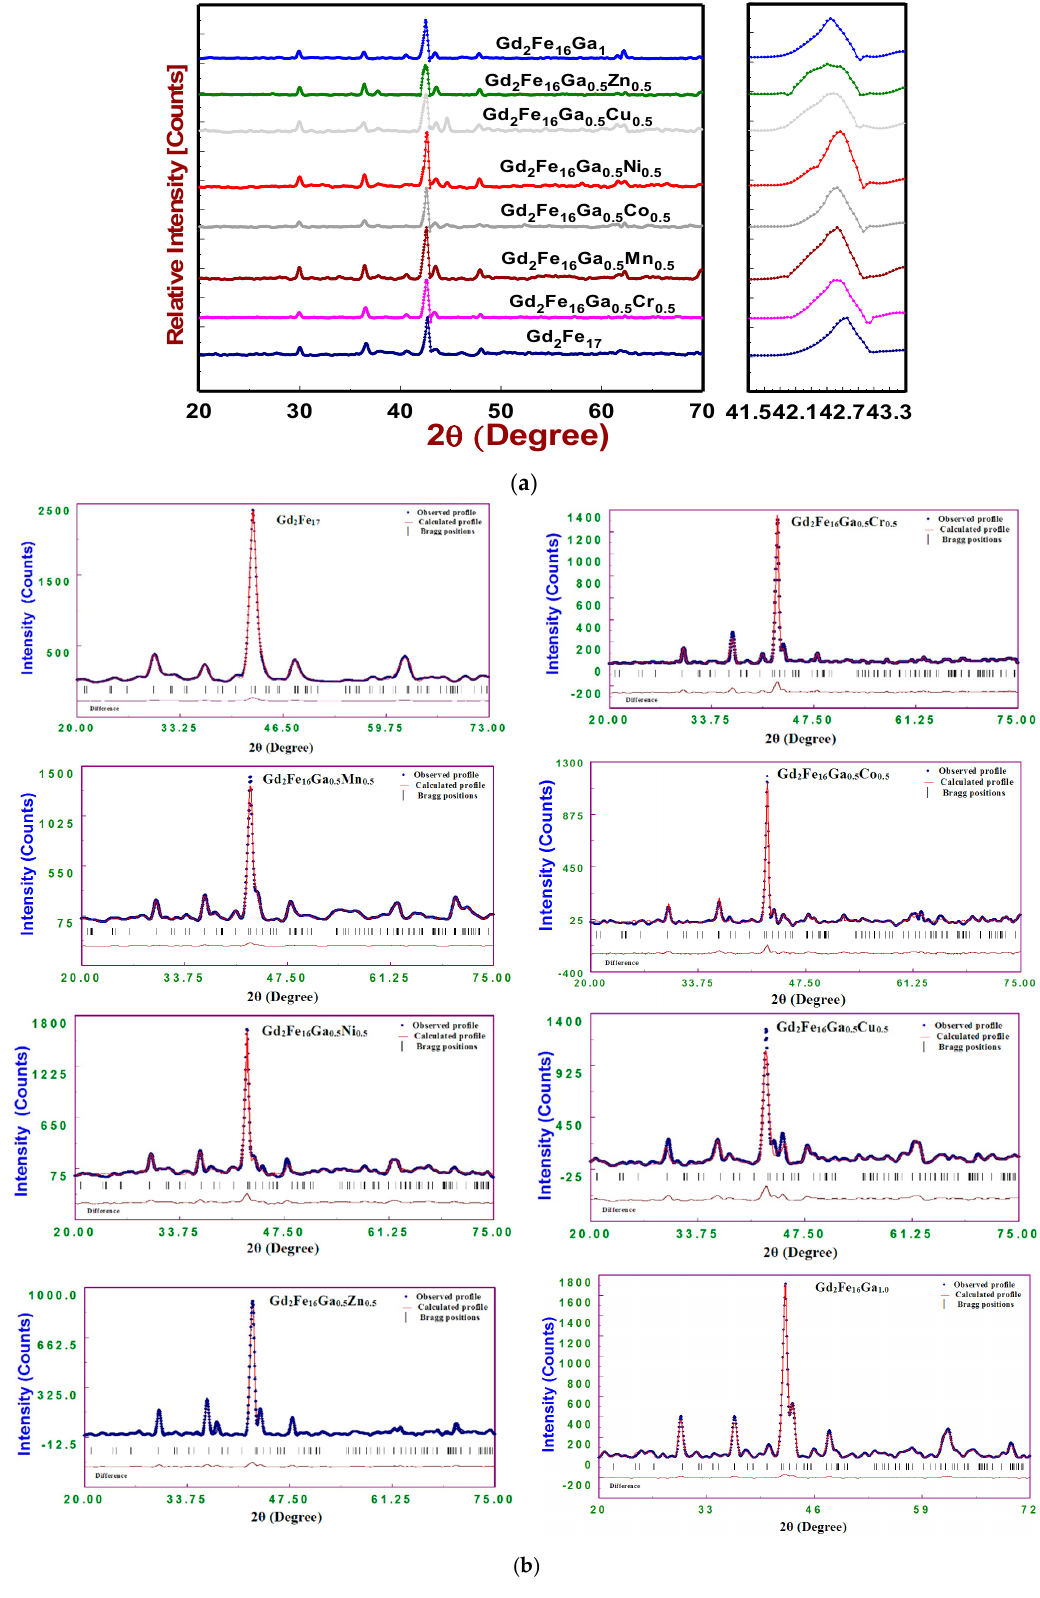
Figure 1. ( a ) XRD powder profile for Gd 2 Fe 17 and Gd 2 Fe 16 Ga 0.5 TM 0.5 (TM = Cr, Mn, Co, Ni, Cu, Zn, and Ga). ( b ) Rietveld refined XRD data of Gd 2 Fe 17 and Gd 2 Fe 16 Ga 0.5 TM 0.5 (TM = Cr, Mn, Co, Ni, Cu, Zn, and Ga).